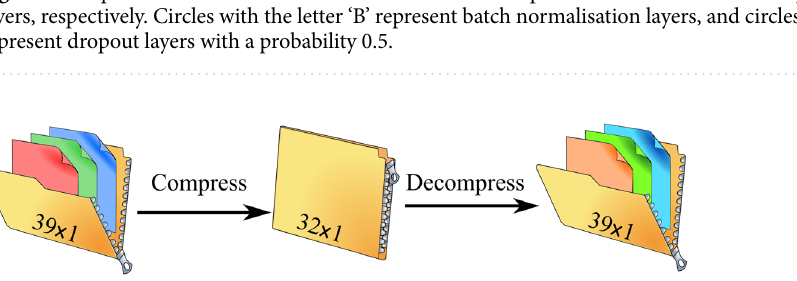
Figure 7. The implemented AE: The 39-dimensional input vector was compressed to a 32-dimensional vector. During reconstruction, the 32-dimensional vector was decompressed to a 39-dimensional